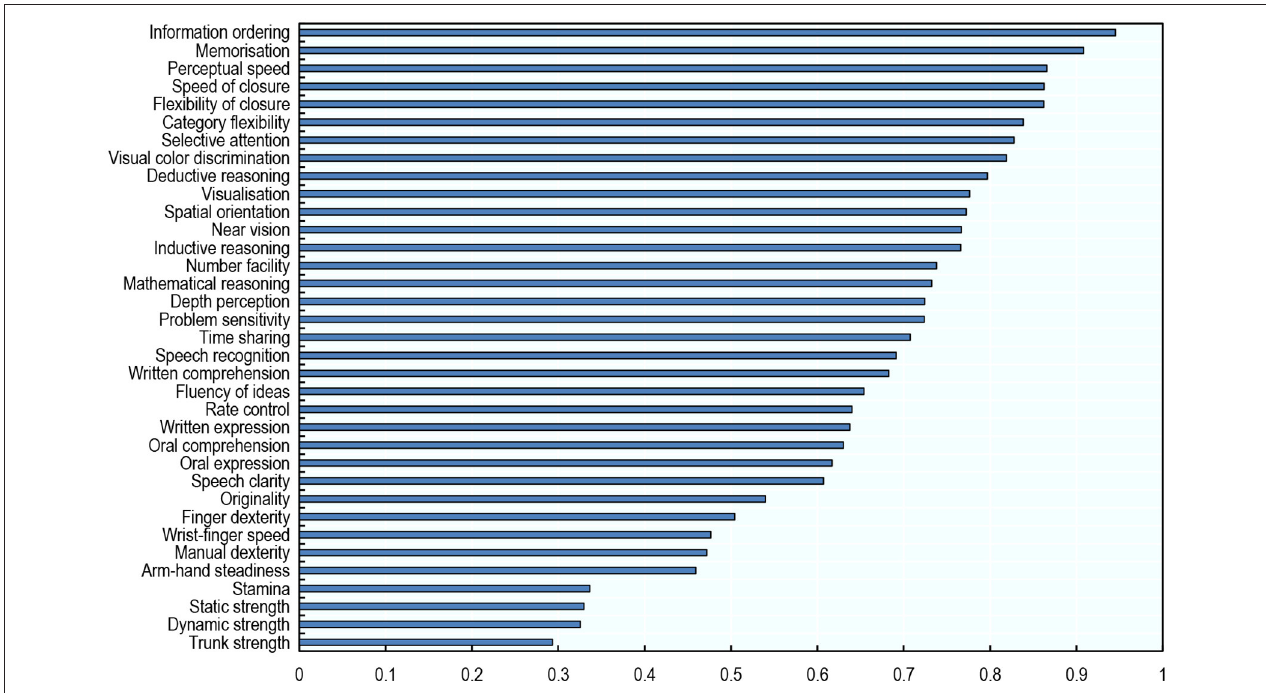
FIGURE 3 | AI has made the most progress in abilities that are required to perform non-routine, cognitive tasks. Progress made by AI in relation to each ability, 2010–2015. The link between O*NET abilities and AI applications (a correlation matrix) is taken from Felten et al. (2019). The matrix was built by an Amazon Mechanical Turk survey of 200 gig workers per AI application, who were asked whether a given AI application—e.g., image recognition—can be used for a certain ability—e.g., near vision. The correlation matrix between applications and abilities is then calculated as the share of respondents who thought that a given AI application could be used for a given ability. To obtain the score of progress made by AI in relation to a given ability, the shares corresponding to that ability are first multiplied by the Electronic Frontier Foundation (EFF) progress scores in the AI applications; these products are then summed over all nine AI applications. Authors’ calculations using data from Felten et al.